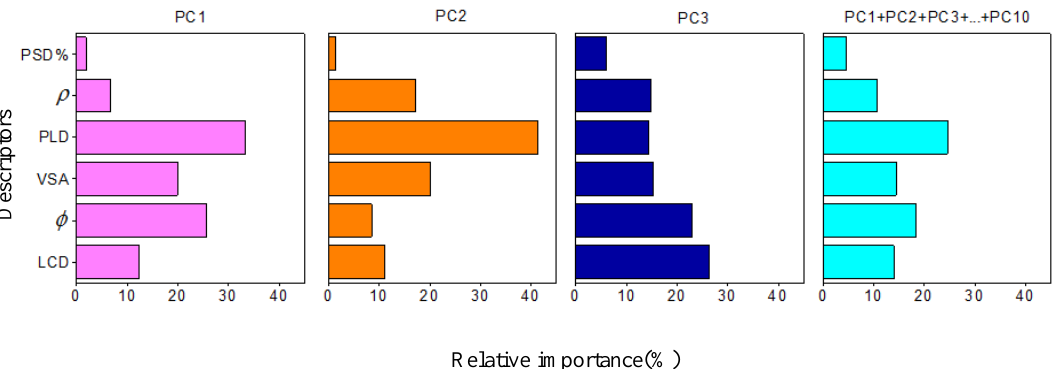
Figure 4. Relative importance of six feature descriptors versus PC1, PC2, PC3, PC1 + PC2 + ... + PC3